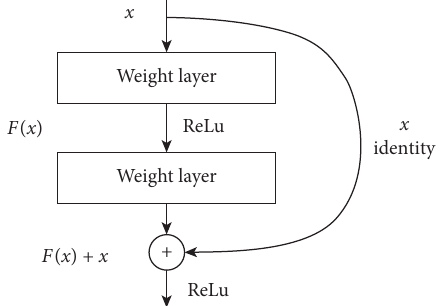
Figure 3: Residual learning: a building block. Source: